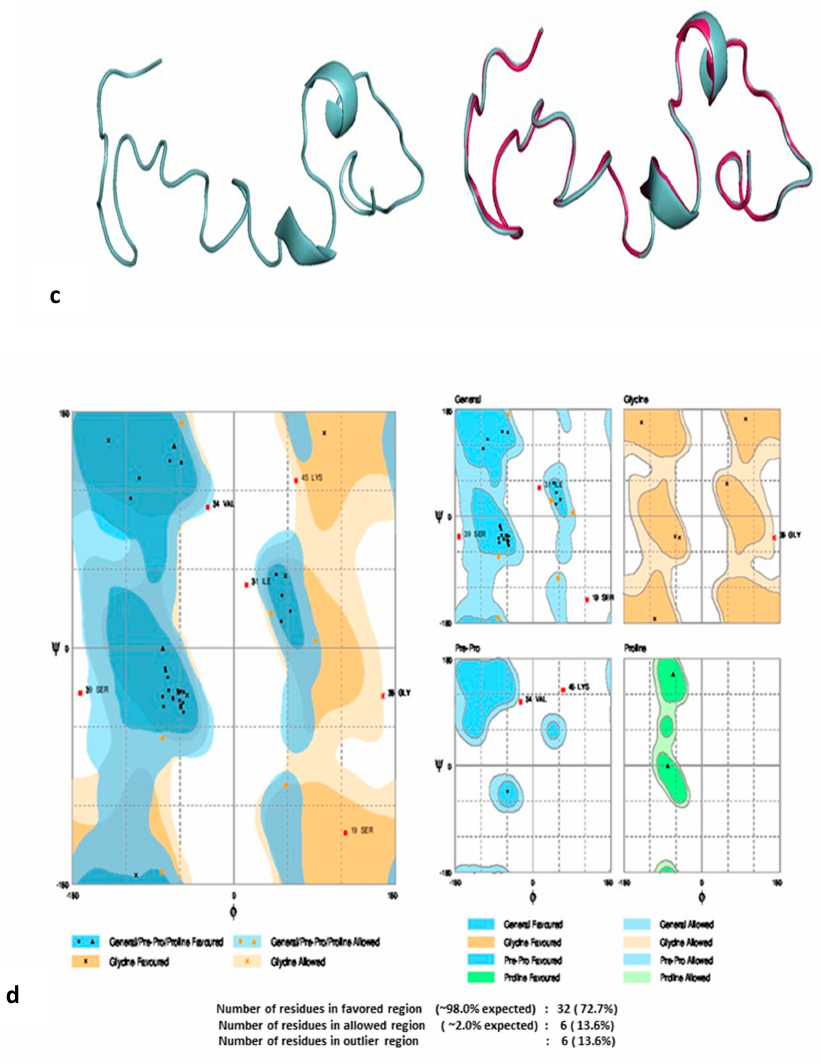
Figure 1. ( a ) The functional domains of the tau gene displays the phosphorylation sites and variations across the six matured tau isoforms, as well as a zoomed view of microtubule associated gene tau location of residues boundaries; ( b ) multiple sequence alignment of tau six isoforms highlighted on complete gene microtubule associated gene tau (MAPT) and R1 and R2 localization of tau with common functional domains of tau isoforms, i.e., the VQIINK and the VQIVYK of the tau gene domains contain R2 and R3 with SER/TYR/THR residues, which are involved in the phosphorylation active sites; ( c ) the homology modeled tau protein (cyan colored) structure superimposed with the 3D structure of human tau in red; ( d ) Evaluation of steriochemical quality of modeled tau protein with RAMPAGE analysis (Ramachandran plot) showing 98.0% of residues were found in the favored region (thick blue background with dark square and triangle dots) general pre-pro/proline favored, general pre-pro/proline allowed region (light blue background with yellow square and triangle dots) 2.0% in the glycine favored (dark yellow background with squared dark triangle) glycine allowed (light yellow back ground with dark squared triangle), and none in the outlier regions (white). Four different portions were displayed in (right side) General, Glycine, Pre-proline and Proline amino acids distribution based up the ψ and ϕ angles.